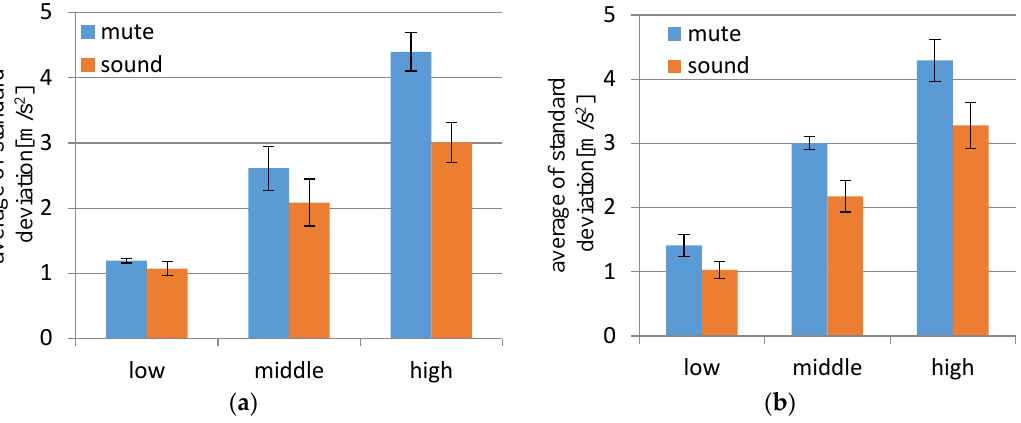
Figure 10. Results for average of standard deviation of detected centripetal acceleration in each target speed: ( a ) condition “mute” followed by condition “sound”; ( b ) condition “sound” followed by condition “mute”.